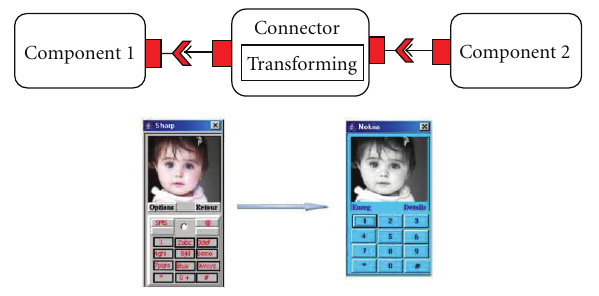
Figure 26: Image of color (grayscale).